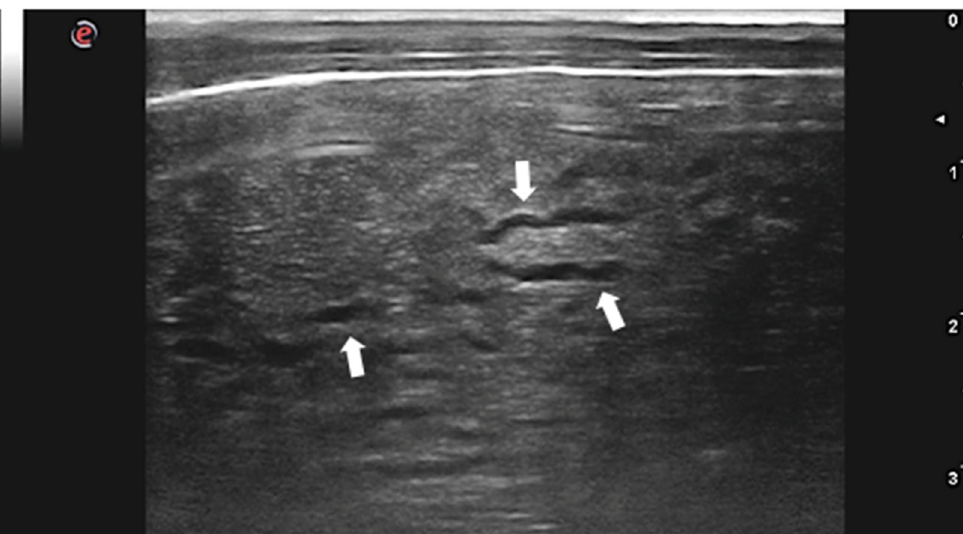
Figure 3. Lamb liver with intraparenchymal anechoic tracts produced by C. tenuicollis migration (arrows). Courtesy of the Veterinary Teaching Hospital, University of Sassari (Italy).